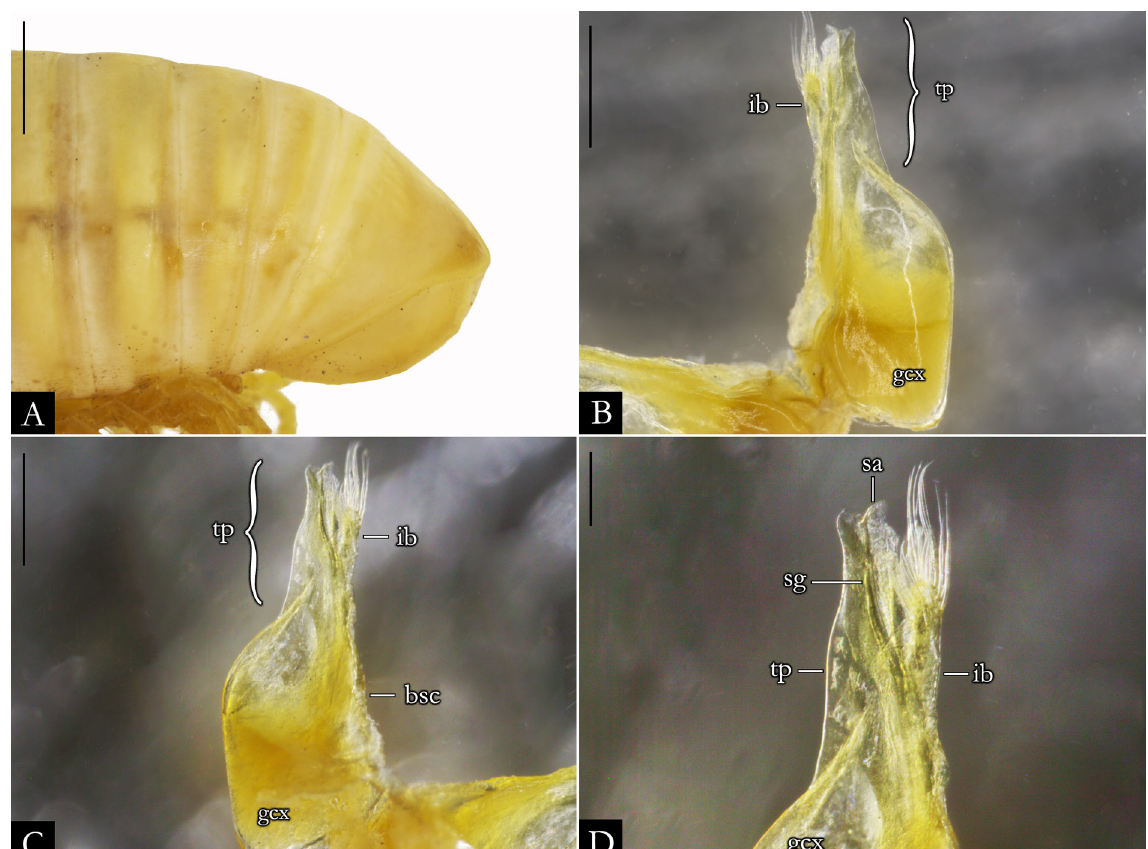
Fig. 119. Pseudonannolene scalaris Brölemann, 1902, holotype, ♂ (MZSP 232). A . Posterior region. B . Right gonopod, in oral view. C . Right gonopod, in anal view. D . Detail of telopodites, in anal view. Abbreviations: see Material and methods. Scale bars: A = 1 mm; B–C = 0.5 mm; D = 0.2